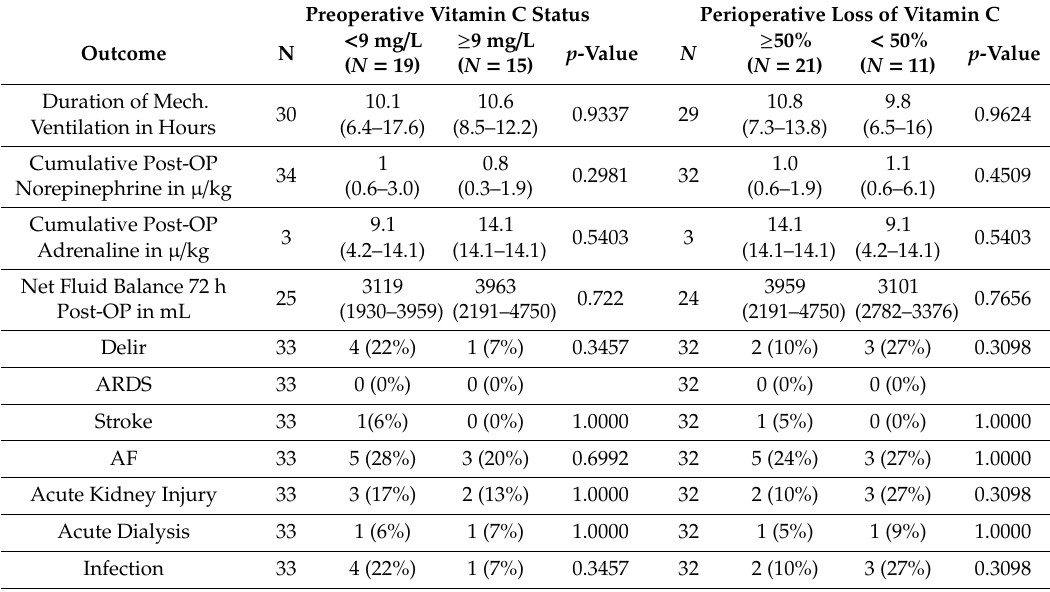
Table 4. Association of perioperative vitamin C levels with organ dysfunction. ARDS, acute respiratory distress syndrome; AF, new postoperative atrial fibrillation; N, number of patients. Data presented as median (interquartile range) or amount (%).